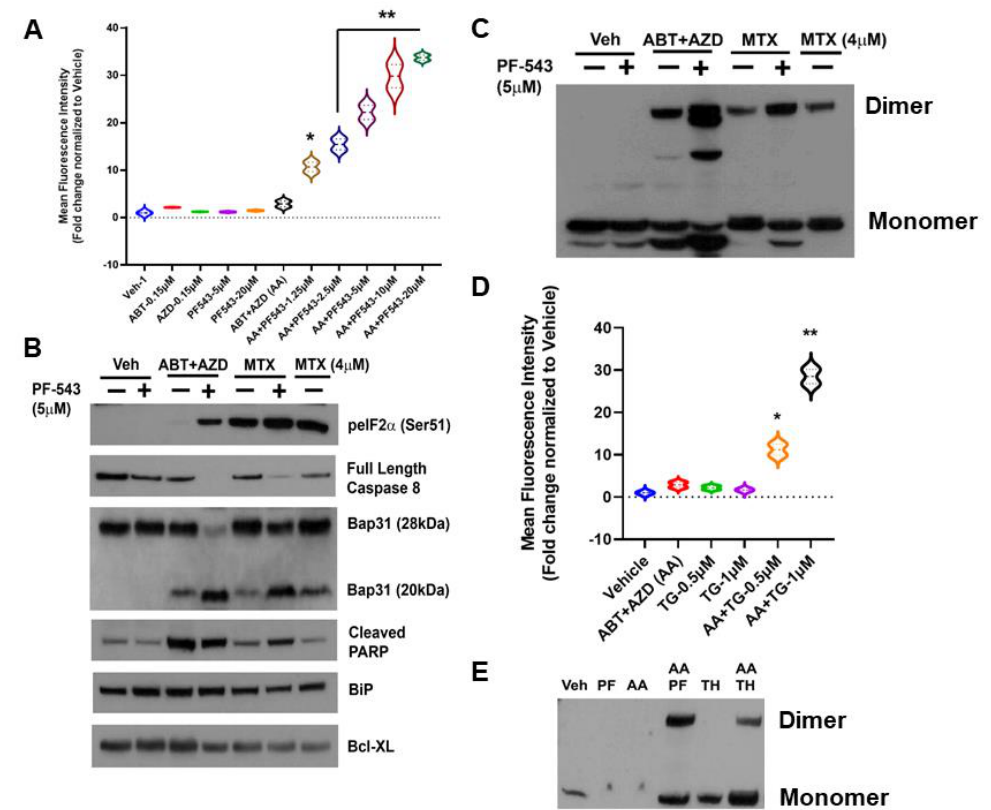
Figure 2. SphK Inhibition enhances the production of a dimeric form of ectoCRT by direct targeting of Bax/Bak with the Bcl-2 family BH3-mimetic inhibitors ABT-263 (Bcl-2 and Bcl-XL) and AZD-5991 (Mcl-1). ( A ). In DLD-1 cells, ABT and AZD alone or in combination had no effect on the cell surface exposure of ectoCRT. PF-543 alone also had no effect on ectoCRT exposure as high as 20 µM. In combination with ABT/AZD, PF-543 dose dependently induces cell surface exposure of ectoCRT. Statistical analysis was performed using one-way ANOVA followed by Tukey’s multiple comparison test. (* , **) Asterisks indicate significant changes as reported in results section. ( B ). To determine whether ABT/AZD ± PF-543 activated Caspase 8, we examined levels of Pro-Caspase 8 (Full length) and cleavage of the Casp8 substrate Bap31. ABT/AZD and MTX alone induce Casp8 activity and Bap31 cleavage. PF-543 enhanced these effects for both ABT/AZD and MTX ( n = 3). ( C ). ABT/AZD and MTX induce the formation of dimeric CRT (non-reducing conditions) and PF-543 enhances these effects ( n = 3). ( D ). Activation of Bak/Bax induces pore formation allowing for ER luminal Ca 2+ leakage to the cytosol. The activity of SERCA can attenuate cytosolic Ca 2+ levels by replenishing the ER. Inhibition of SERCA with Thapsigargin (TH) enhances ABT/AZD induced ectoCRT